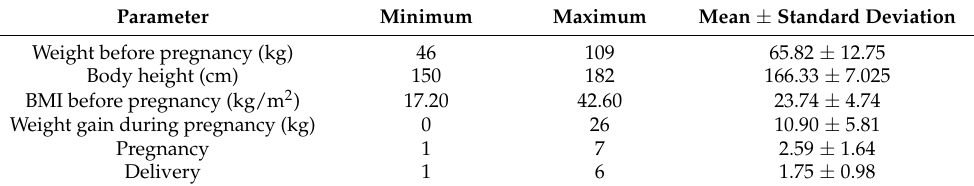
Table 1. Maternal